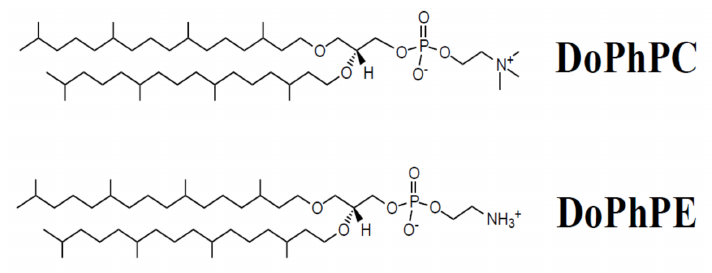
Figure 1. Sketch of the structures of the lipids used, 1,2-di-O-phytanyl-sn-glycero-3-phosphocholine (DoPhPC) and 1,2-di-O-phytanyl-sn-glycero-3-phosphoethanolamine (DoPhPE).